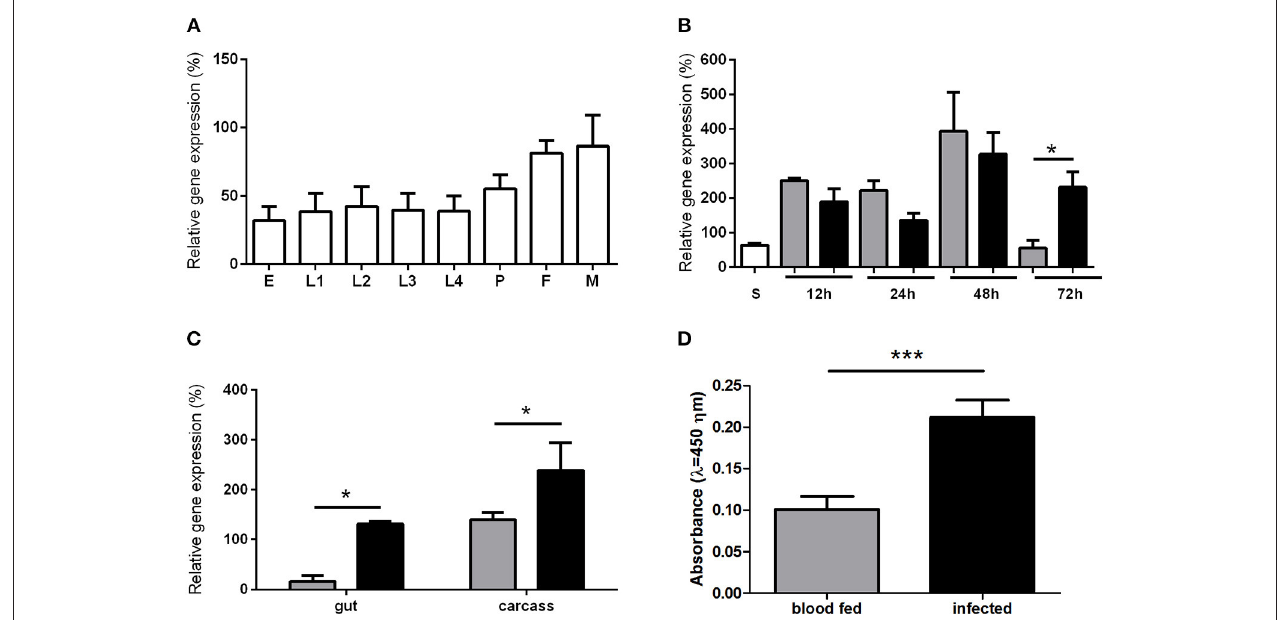
FIGURE 2 | LlTGF- β gene expression in sand flies. (A) L. longipalpis development stages: egg (E), larval stages (L1, L2, L3, L4), pupae (P), adult female (F), and male (M). (B) L. longipalpis fed on sucrose (S) are represented by white bar. Flies collected at 12, 24, 48, and 72h post blood meal are represented by gray bars or after feeding on infective blood represented by black bars. (C) LlTGF- β expression in gut and carcass 72h after ingestion of blood without (gray bars) or with (black bars) Leishmania . Gene expression by semi-quantitative PCR was calculated relative to histone or RP49 L. longipalpis reference genes. (D) ELISA for detection of LlTGF- β protein 72h after blood or infective meal. Bars represent mean with standard error of 3 replicates. Significant differences were evaluated by t -test and Mann-Whitney post-test (* p < 0.05; *** p <